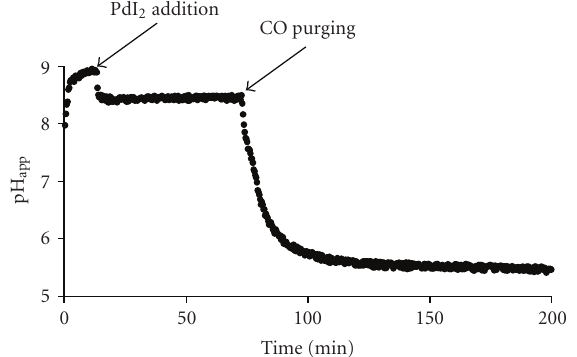
Figure 4: [KI] = 4.8 · 10 − 1 mol/dm 3 ; [PdI 2 ] = 2.22 · 10 − 3 mol/dm 3 ; CO flow = 6mL/min; 25 mL of “wet” methanol.